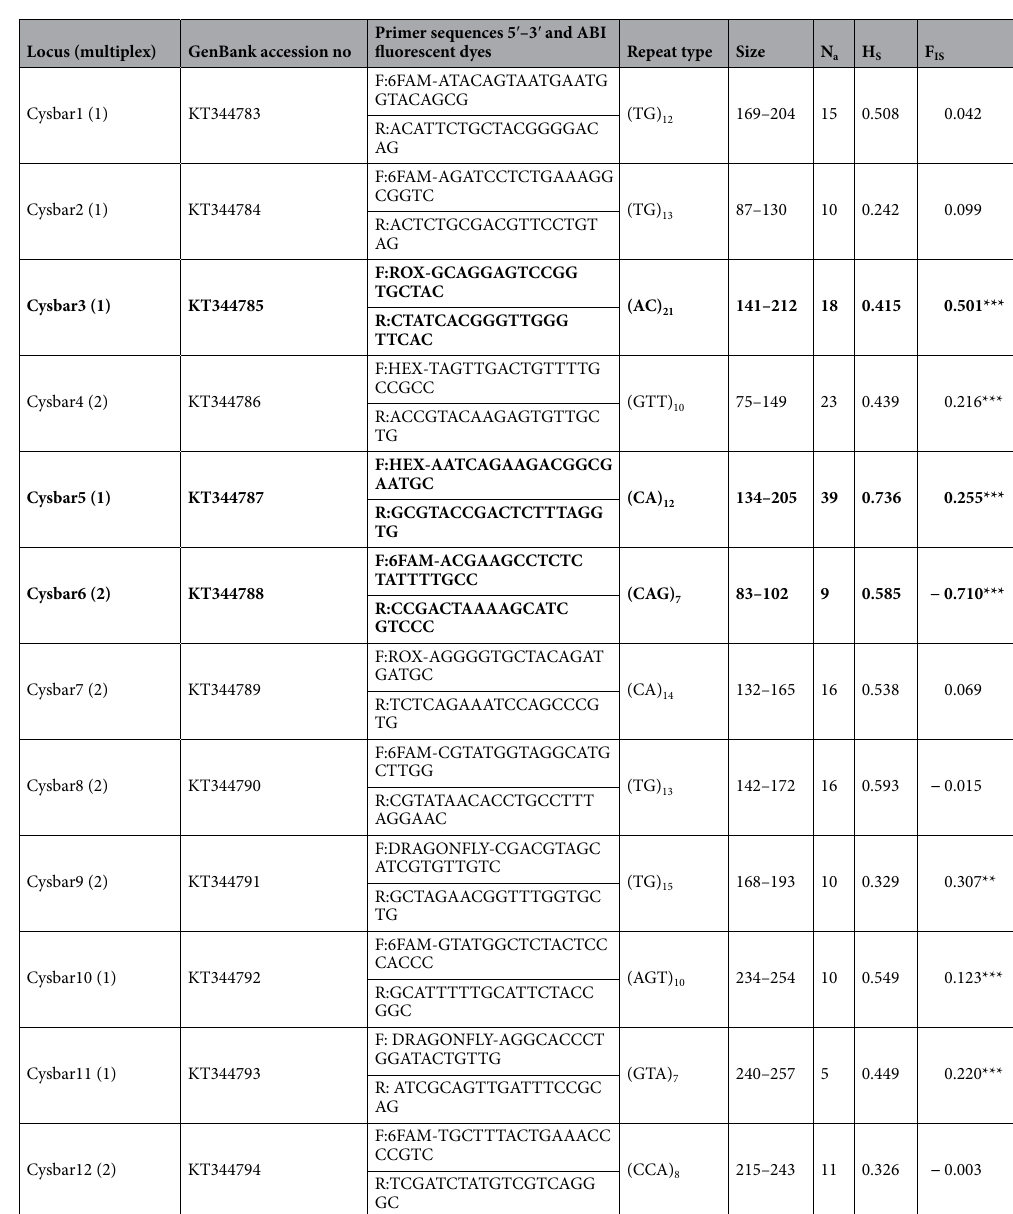
Table 2. Characterization of twelve microsatellite markers developed in Gongolaria barbata (15 sites sampled, N = 375 unique genotypes). N a : Number of alleles, H S : Nei’s genetic diversity within subsample; F IS : fixation index and its p -value from U test for heterozygote deficiency or excess (** p -value < 0.01, *** p -value < 0.001, non-significant for all the other loci). The three loci bolded were removed from the final